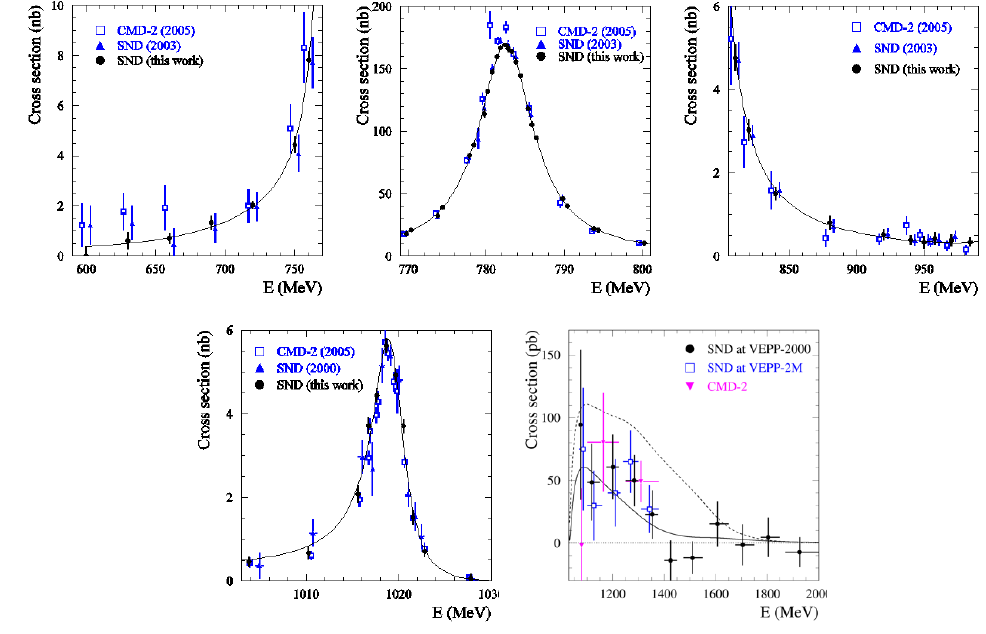
Figure 1. The e + e − → π 0 γ cross section measured by SND using the full VEPP-2M data sample in comparison with the previous most accurate measurements. The curve is the result of the VMD fit. Only statistical errors are shown. The systematic errors are 3.2%, 3%, and 6% for SND (2000), SND (2003), and CMD-2 (2005) data, respectively. Our systematic uncertainty at the ω and φ peaks is 1.4%. In the energy range above φ meson mass the preliminary results based on data accumulated at VEPP-2000 are